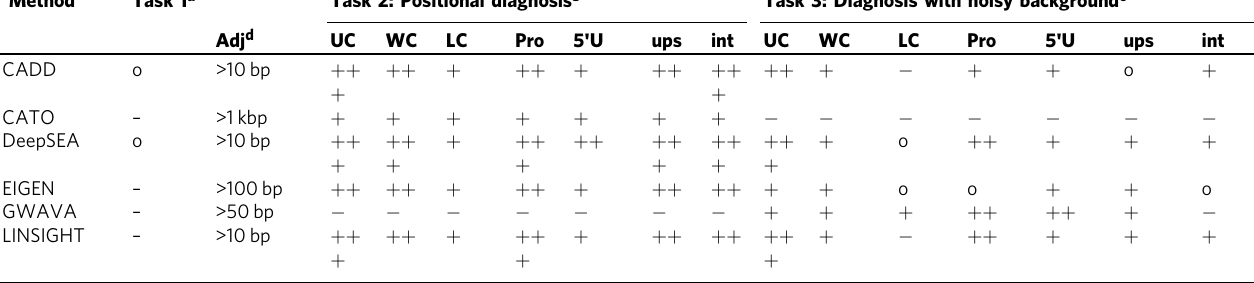
Table 2 Performance of six tools on three biological tasks Method Task 1 a Task 2: Positional diagnosis b